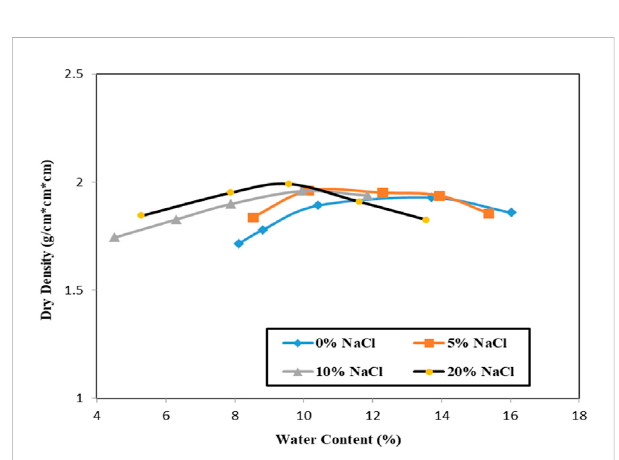
FIGURE 7 Dry density versus moisture content of different NaCl% for soil at 3 m depth.